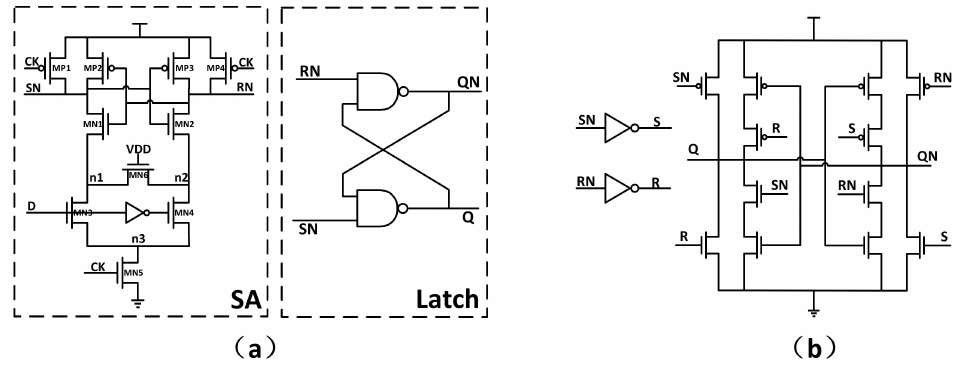
Figure 2. ( a ) Schematic of the conventional sense-amplifier-based flip-flop (SAFF); ( b ) Schematic of the latch in Nikolic’s SAFF.